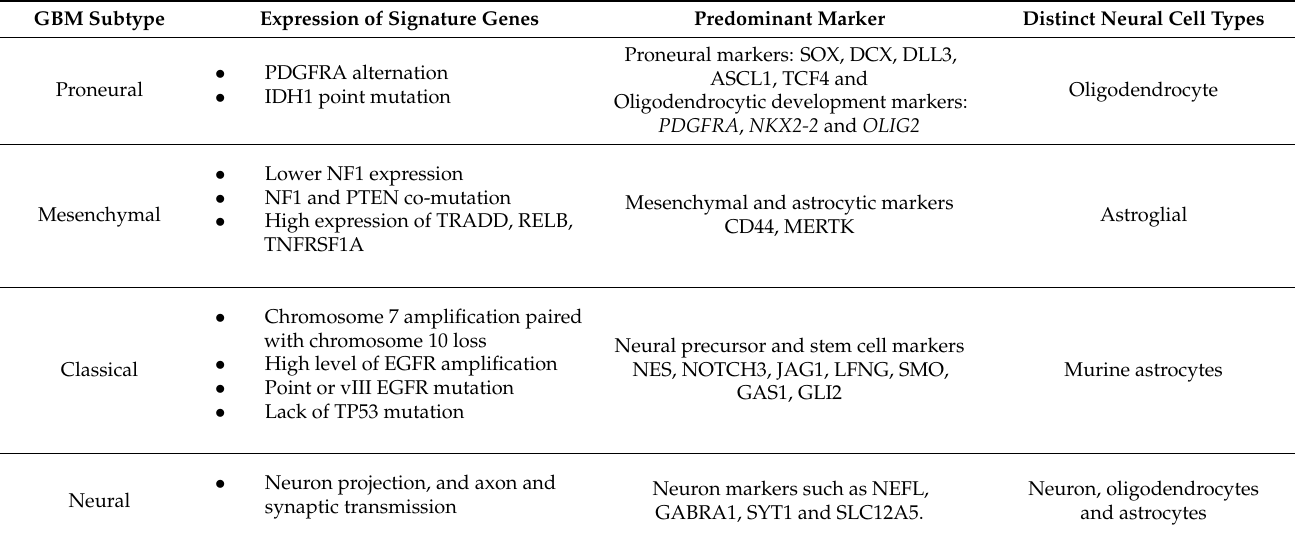
Table 1. Glioblastoma (GBM) molecular